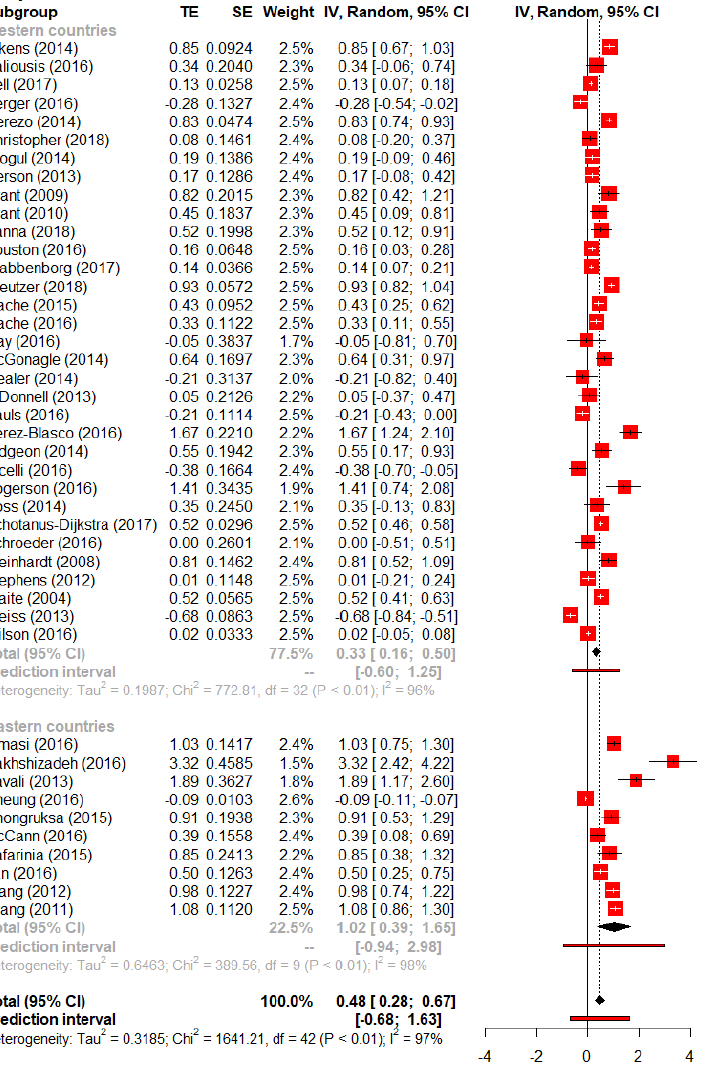
Table 3. Summary of pooled effect sizes.